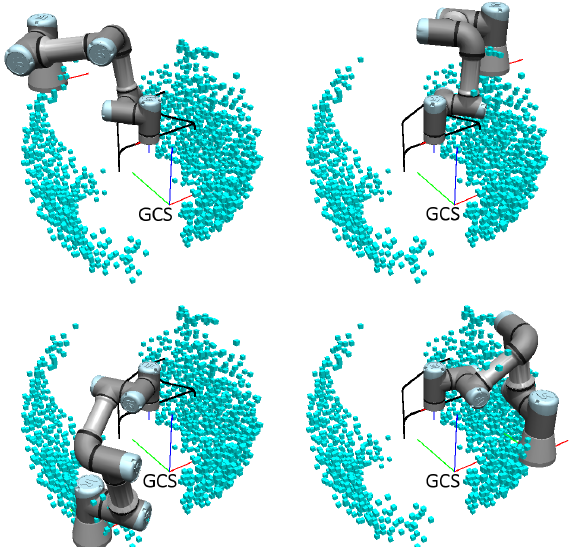
Figure 4. Example of a grid of valid robot locations for a given trajectory (A1). Each blue point represents a possible position of the robot base center point; the robot is displayed in four distinct sample locations. GCS represents the global coordinate